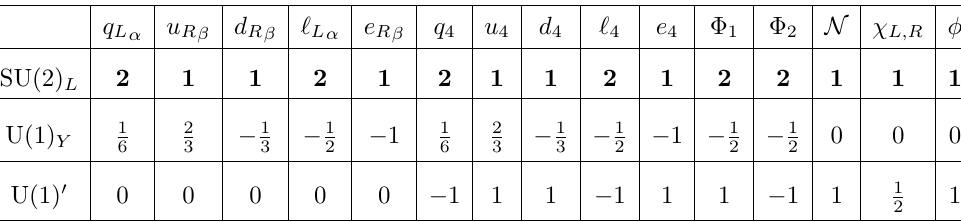
Table 2 . Irreducible representations of the fields of the model under the electroweak SU(2) L × U(1) Y × U(1) 0 gauge symmetry. The fields q Lα , ‘ Lα are left-handed SM doublets while u Rβ , d Rβ , e Rβ are right-handed SM singlets where α, β label the three families of quarks and leptons. The two right-handed neutrino fields N R1 , 2 are written as a Dirac pair N